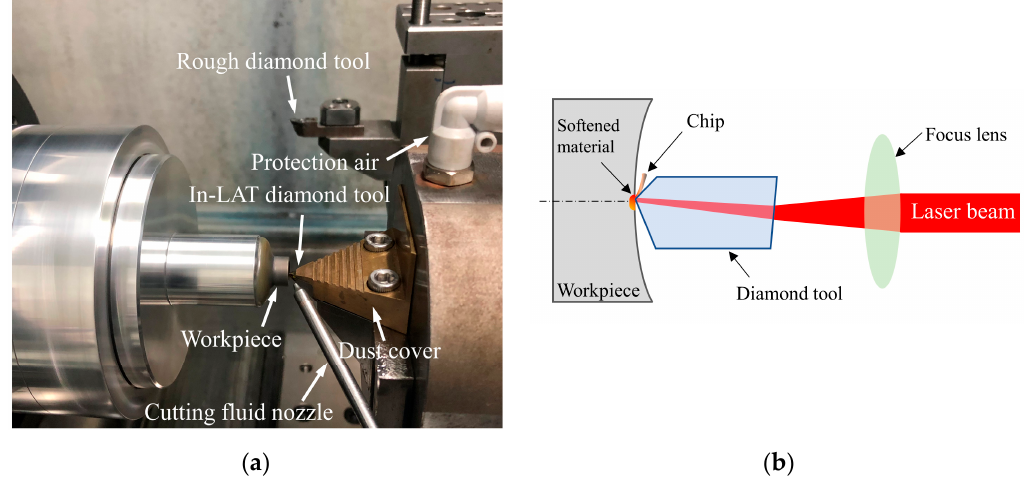
Figure 3. ( a ) The experimental setup, and ( b ) the schematic diagram of the in-process-heat laser assisted turning (In-LAT) system.